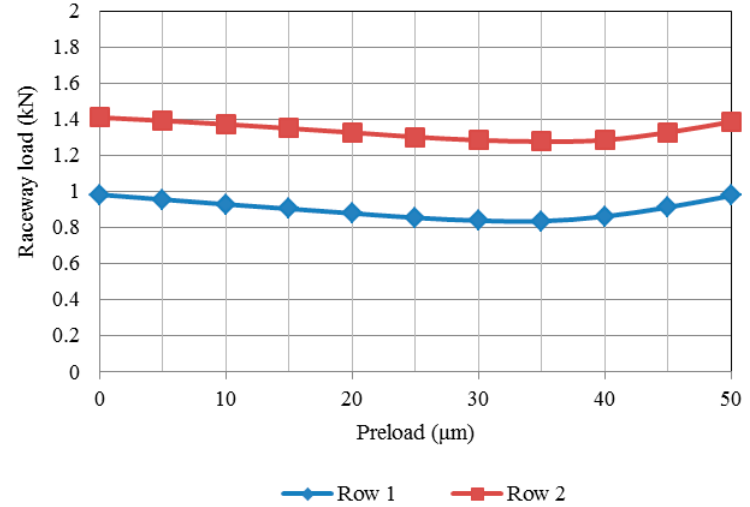
Figure 11. Raceway load over preload of hub bearing.